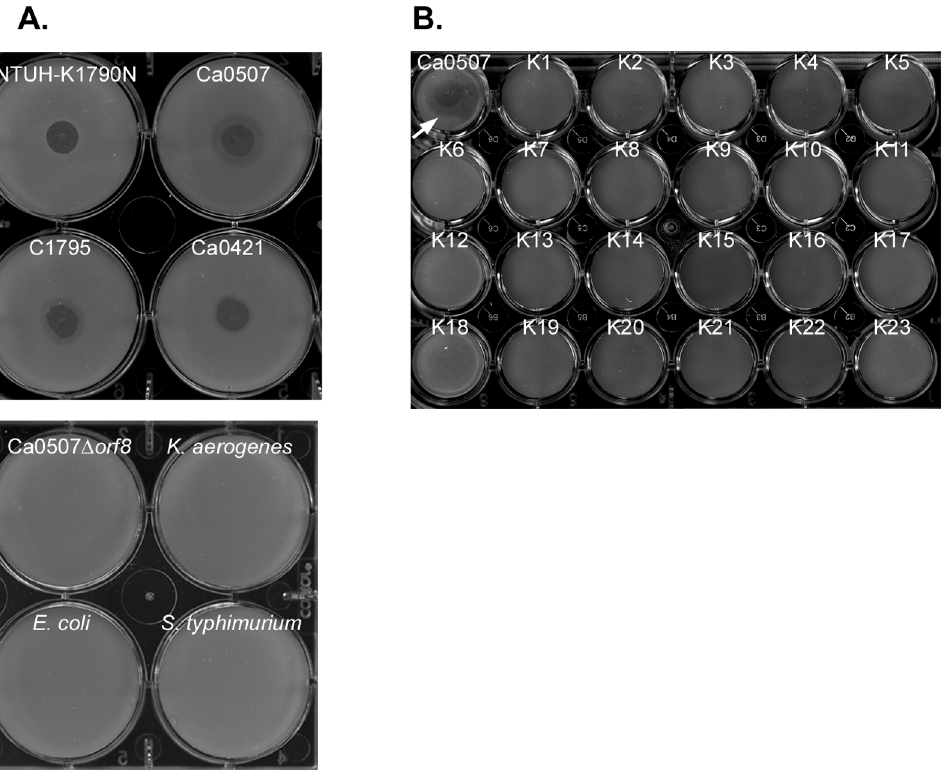
Figure 3. Bacterial host range of phage 0507-KN2-1. ( A ) Upper panel showing spot tests of 0507-KN2-1 (10 9 ) on K. pneumoniae KN2 strains as indicated. Lower panel showing spot tests on Ca0507 isogenic mutant with a deletion of gene orf8 in cps (Ca0507 D orf8 ), K. aerogenes, E. coli 29522 and S. typhimurium ATCC14028. ( B ) Spot tests of 0507-KN2-1 (10 9 ) on K. pneumoniae 77 K serotype reference strains and a new type A1517. Ca0507 was used as a positive control (indicated by a white arrow). Negative reactions were observed in all reference strains and A1517 (data on K24-K77 and A1517 not shown).